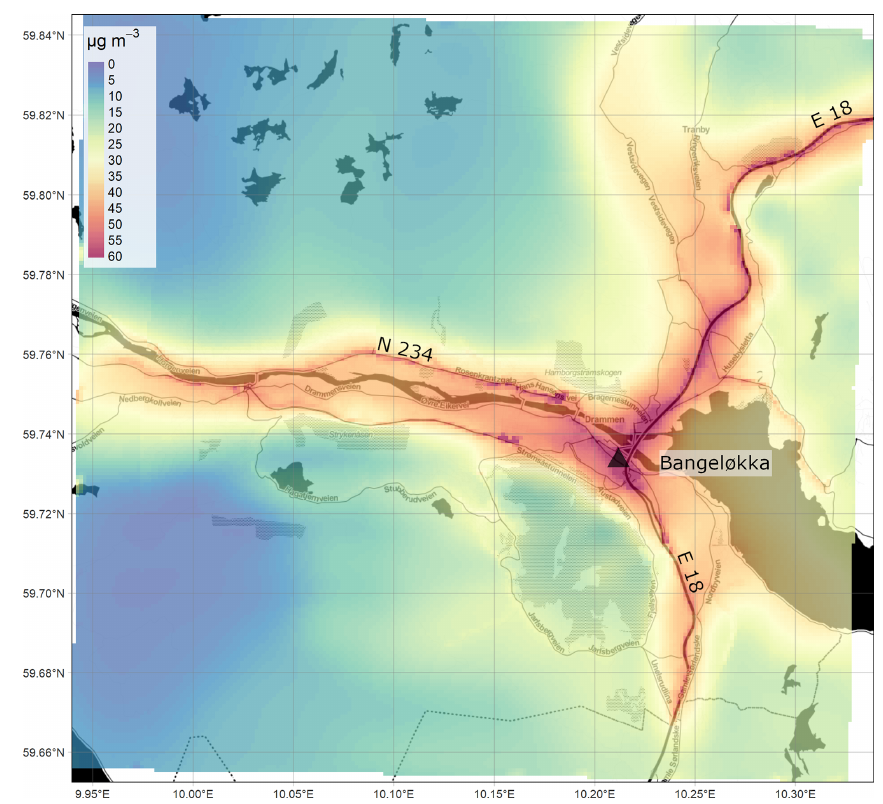
Figure 5. Annually averaged NO 2 concentrations (µgm − 3 ) from the EPISODE model over the Drammen domain at 100m × 100m horizontal resolution. The concentrations are derived from the receptor point concentrations and then re-gridded onto a 100m grid. The colour scale shows the range in annual mean NO 2 concentrations between 0 and 40µgm − 3 . The black triangles indicate the locations of the air quality observation stations (Table 7). The dark shaded areas represent the sea, lakes, and rivers. The black lines are roads. © OpenStreetMap contributors 2019. Distributed under a Creative Commons BY-SA